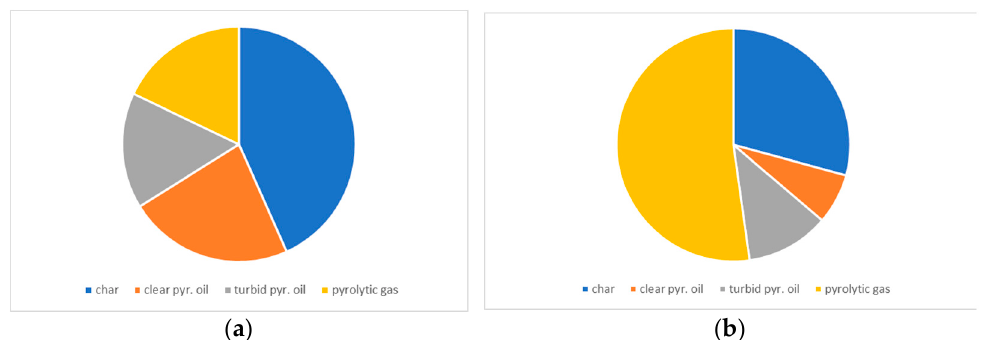
Figure 3. Migration of nitrogen in pyrolysis products: ( a ) for contaminated foils; ( b ) for mixed plastics.